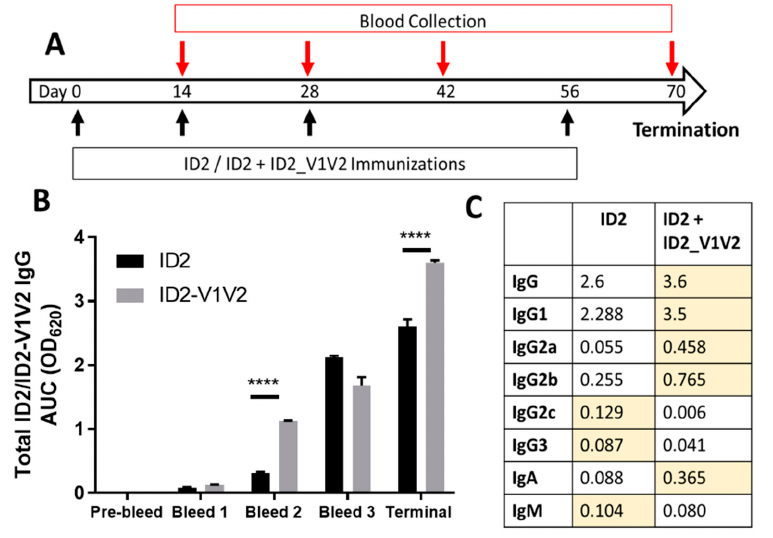
Figure 3. ID2_V1V2 immunogenicity studies in BALB/c mice. ( A ) Vaccination strategy. Mice were vaccinated with either ID2 (5 µg/mL) or ID2 + ID2-V1V2 (5 µg + 10 µg) at Day 0, 14, 28 and 56 with